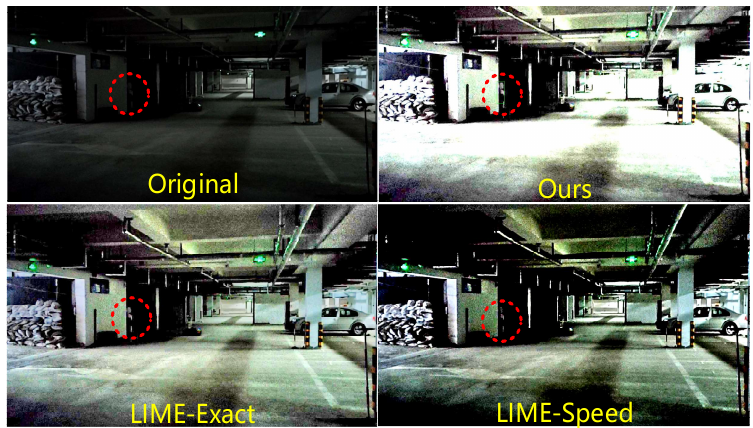
Figure 12. This is a figure. Schemes follow the same formatting.